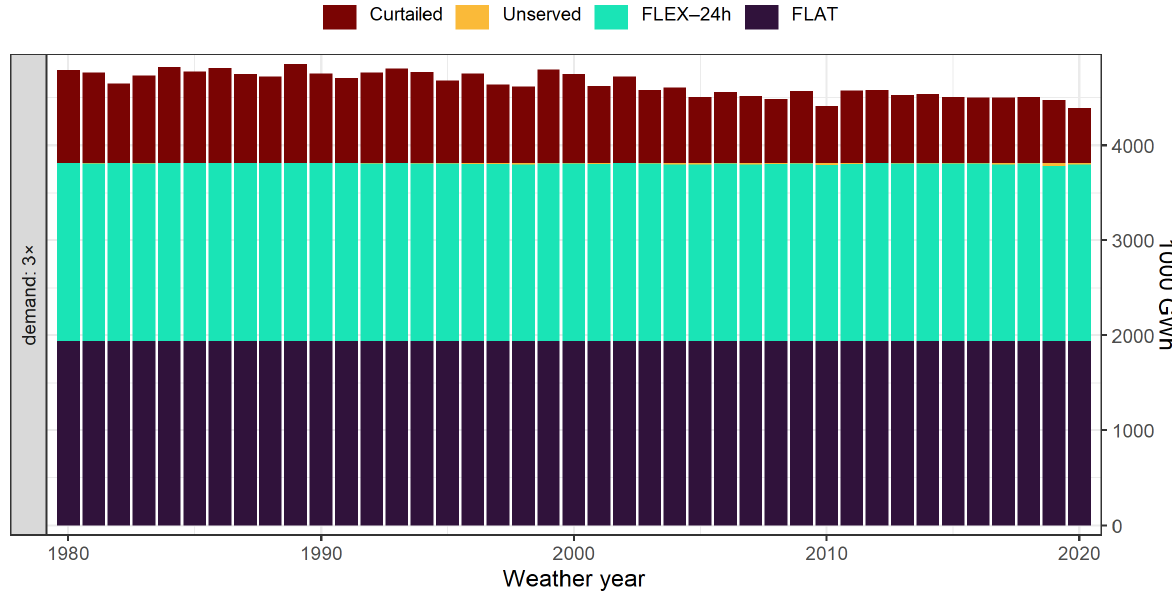
Figure 17. Demand structure by year and curtailed generation.